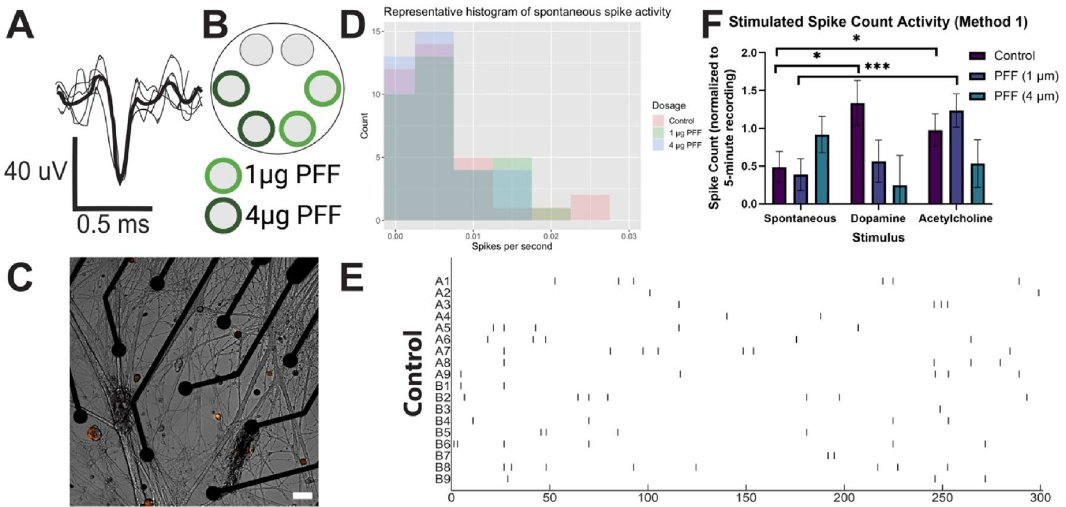
Figure 6. Functional assessment of neurons using microelectrode arrays (MEA). ( A ) Representative waveform ( B ) Schematic made in Biorender. ( C ) Merged image of neurons near 30 µm diameter electrodes (black). Orange = PFF tag. Scale = 100 µm. ( D ) Representative histogram of detected action potential rate as spikes per second from spontaneous activity recorded on day 20 (upper 7% of values cropped). Color indicates experimental group (red = control, green = 1 µg PFF, blue = 4 µg PFF). ( E ) Representative raster plot of spontaneous spike activity over time (seconds). ( F ) Estimated means of spike count (5-min period) by stimulation and PFF dosage (method 1). Error bar = SEM. N = 1–4, number of MEAs = 1–4, wells = 2–11, number of electrodes = 10–50. (N > 1 outside day 28, 4 µg PFF. Zero-inflated, negative binomial